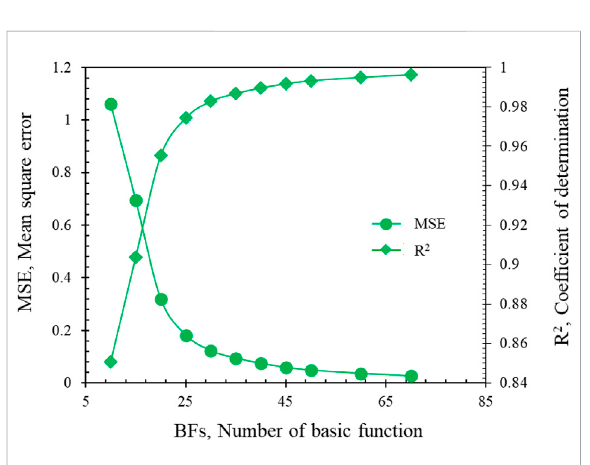
FIGURE 18 In fl uence of basic function on MARS performance. FIGURE 19